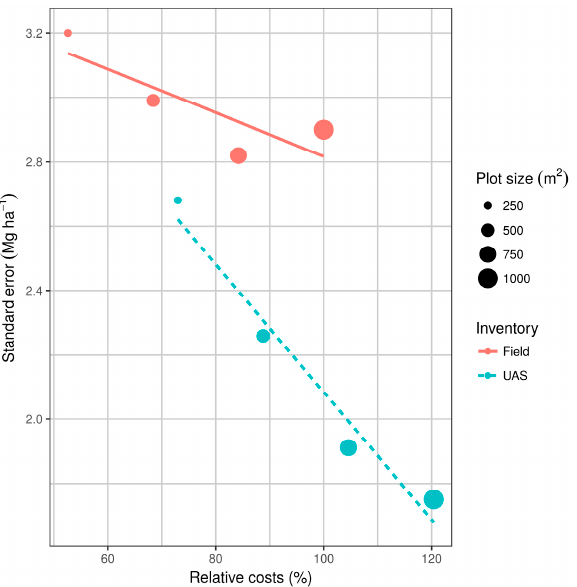
Figure 3. SE estimates and relative costs (RC) for field-based inventories (red) and UAS-assisted inventories (green) with different sample plot sizes (point size). Linear regression lines of the form SE = b 0 + b 1 × RC are added for the field-based and UAS-assisted inventory, respectively, to indicate the trends in the results.